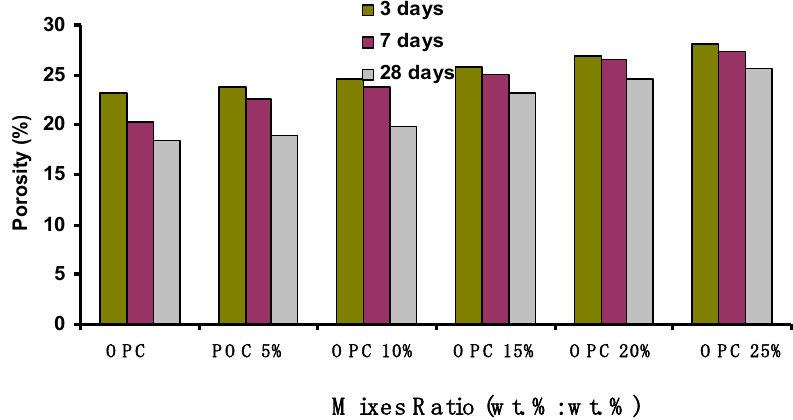
Figure 4. The total porosity of OPC and their mixes ratio with CMW.